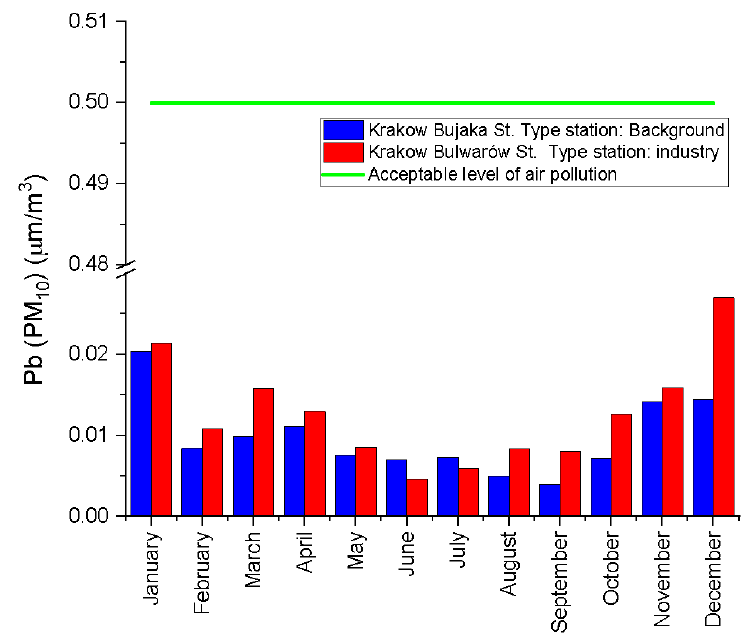
Figure 10. Average concentration of Pb (PM10) in individual months of 2020.